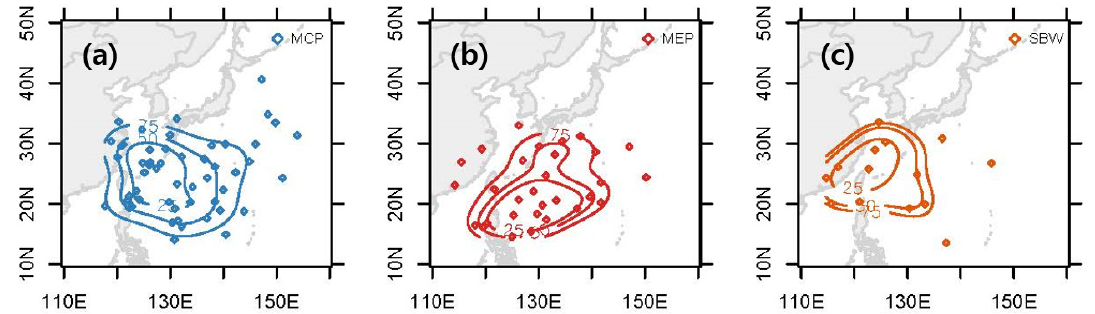
Figure 4. Map of the density circle of tropical cyclone recurving positions during the decay periods of ( a ) moderate central Pacific (MCP), ( b ) moderate eastern Pacific (MEP), and ( c ) strong basin-wide (SBW) El Niño events.